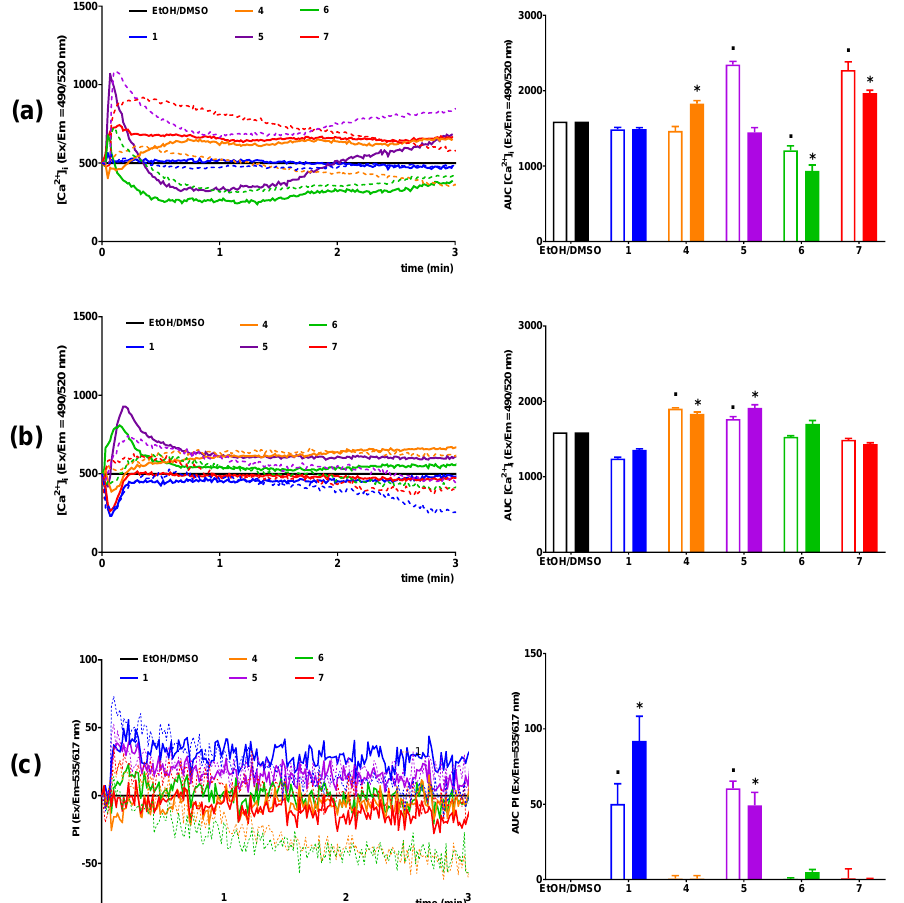
Figure 4. Intracellular Ca 2 + mobilization in MIN6 cells stimulated with p -anisic acid (1), phosphatidylcholines substituted with at anisic and / or palmitoyl acyl residues in di ff erent configurations (4–6), 1-anisoyl-LPC (7), or compound solvent (EtOH / DMSO) at 20 mM ( a ) and 2 mM glucose conditions ( b ), with simultaneous monitoring of membrane integrity via PI incorporaton ( c ). The results are presented as the real-time kinetics of [Ca 2 + ] i and [PI] changes inside the cell during 3-min monitoring as well as AUC. The compounds were tested in 25 and 50 μM concentrations indicated as dashed or full lines and open or closed bars respectively. p < 0.05 for secretion significantly di ff erent from 2 mM glucose control (.) and 20 mM glucose control (*).